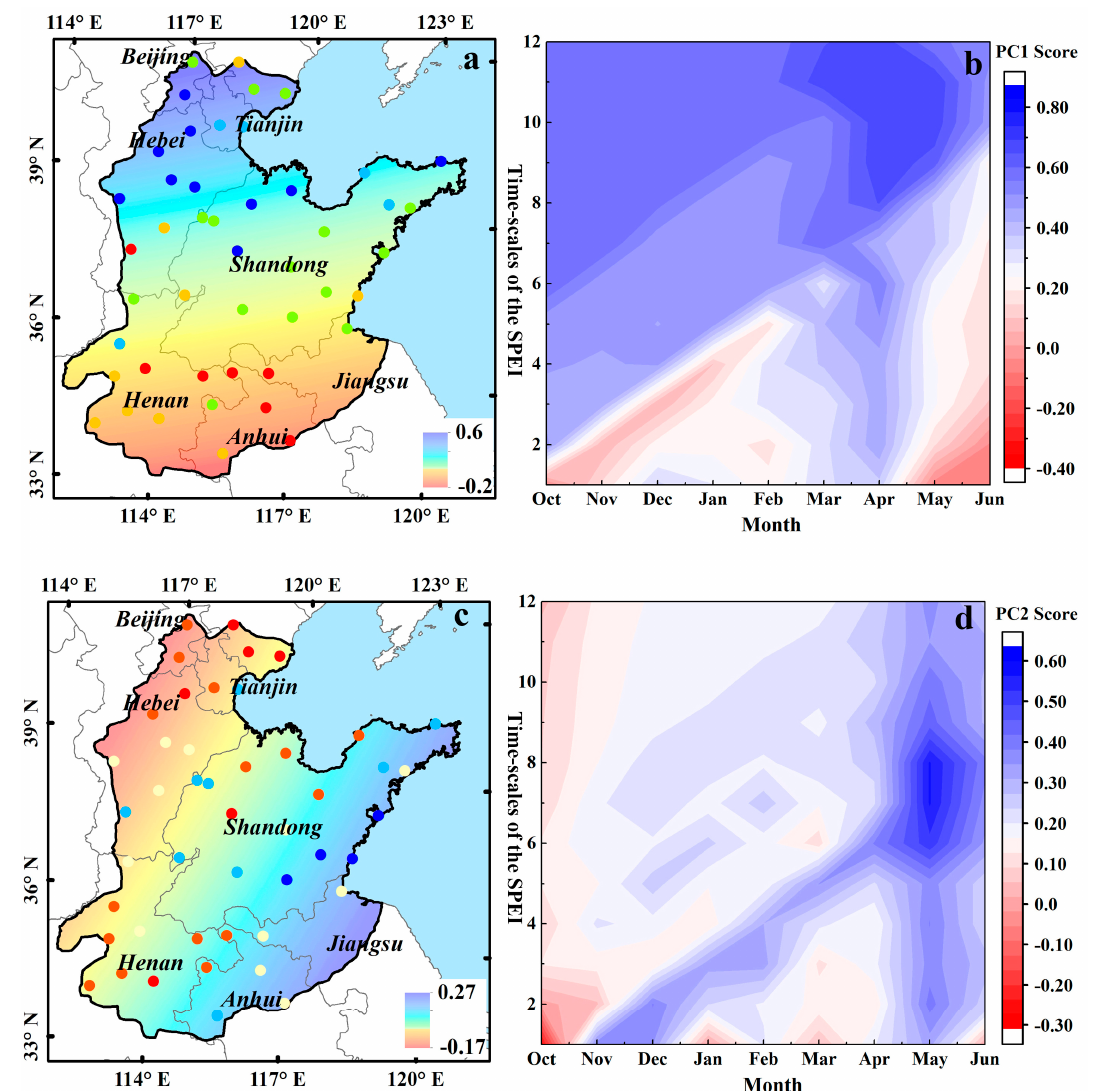
Figure 10. ( a ) The PC-loading map of the first principal components. ( b ) The PC-scores that that represent the first principal components. ( c ) The PC-loading map of the second principal components. ( d ) The PC-scores that that represent the second principal components. We obtained the PC-loading spatial map by the Kriging interpolation method.